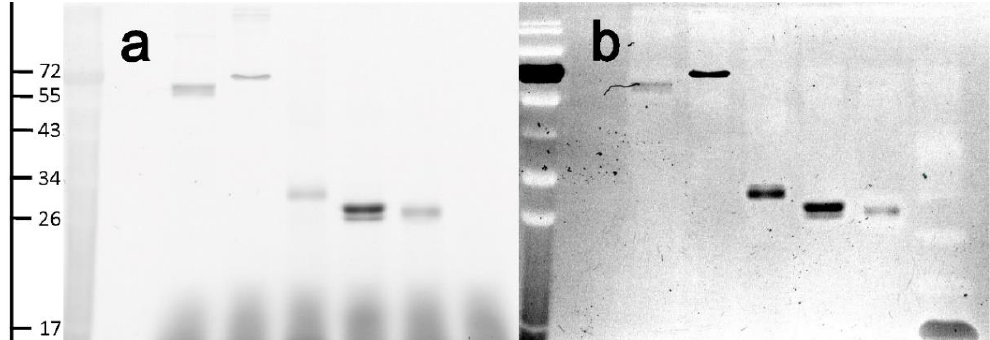
Figure 3. ( a ) Inverted SDS-PAGE fluorescence image of different proteins with Cys residues labeled with Nap-I; ( b ) image of the same gel re-stained with Coomassie R-250. Quantity of protein per band: ca. 1.5 μg.